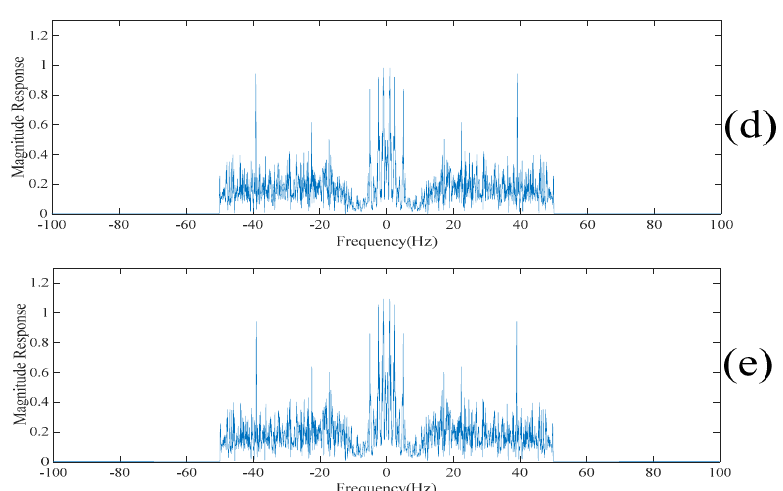
Figure 11. ( a ) The second scale of the electroencephalogram in the frequency domain. ( b ) The fourth scale of the electroencephalogram in the frequency domain. ( c ) The sixth scale of the electroencephalogram in the frequency domain. ( d ) The eighth scale of the electroencephalogram in the frequency domain. ( e ) The tenth scale of the electroencephalogram in the frequency domain.